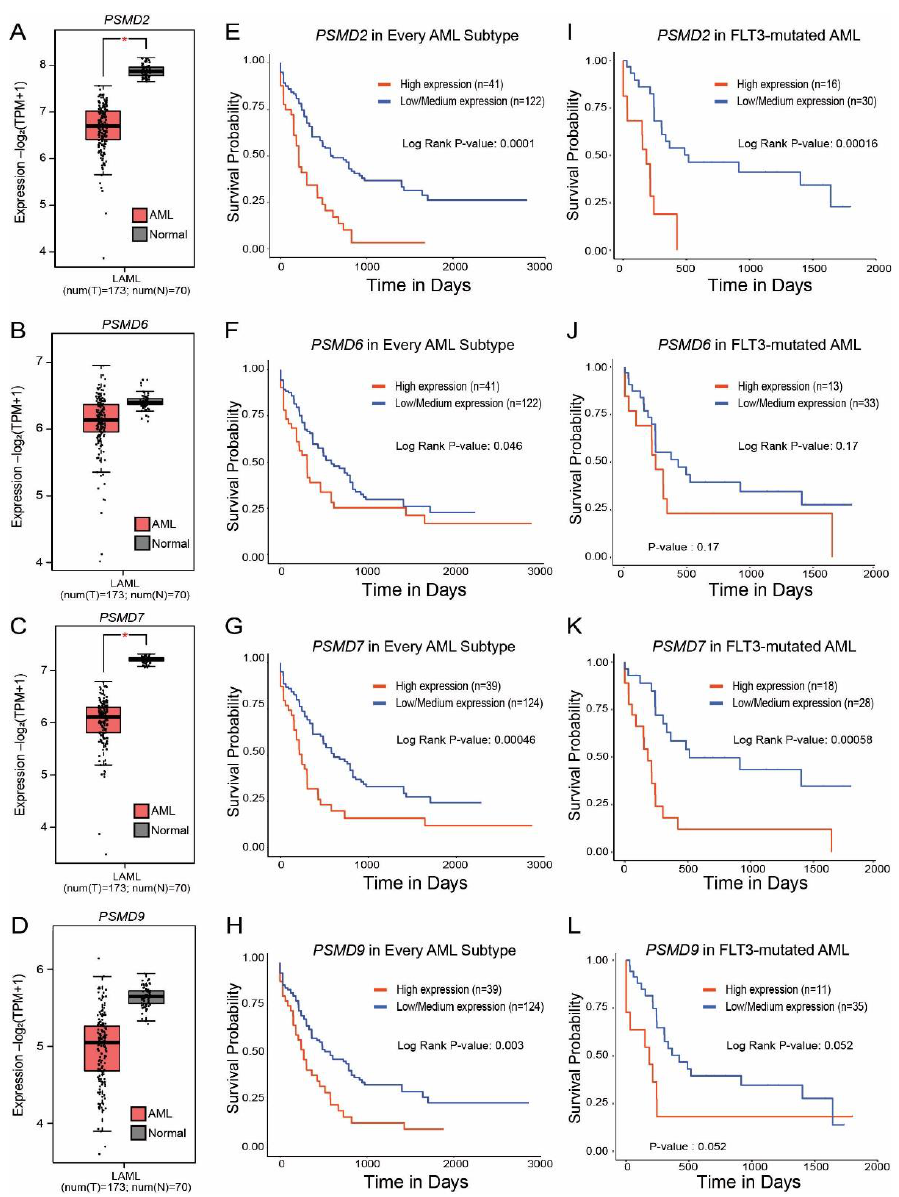
Figure 6. High levels of PSMD2 and PSMD7 mRNA expression correlated with worse outcomes in FLT3-mutated AML. ( A – D ) Box plots show PSMD2 ( A ), PSMD6 ( B ), PSMD7 ( C ), and PSMD9 ( D ) mRNA expression in AML versus normal MNCs. ( E – H ) Kaplan – Meier curves show OS for AML patients with high versus low levels of PSMD2 ( E ), PSMD6 ( F ), PSMD7 ( G ), and PSMD9 ( H ) when all AML subtypes are considered. ( I – L ) Kaplan – Meier curves show OS for FLT3-mutated AML patients with high versus low levels of PSMD2 ( I ), PSMD6 ( J ), PSMD7 (K), and PSMD9 ( L ). Error bars represent SEM (* p < 0.001).